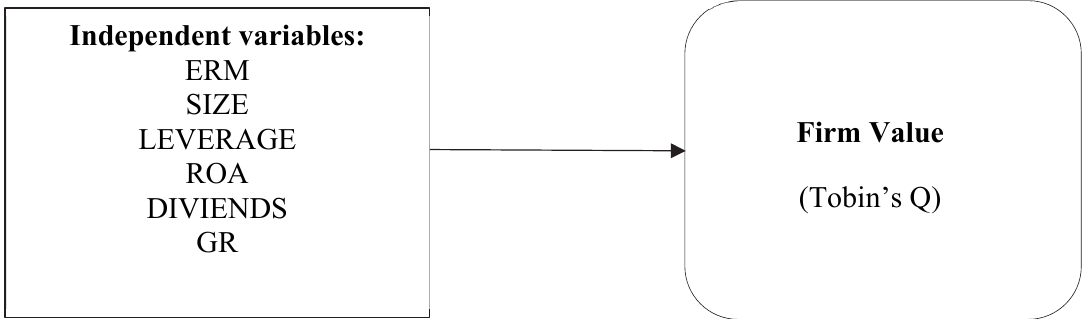
Fig. 1 . Research Model (Source: Compiled by the